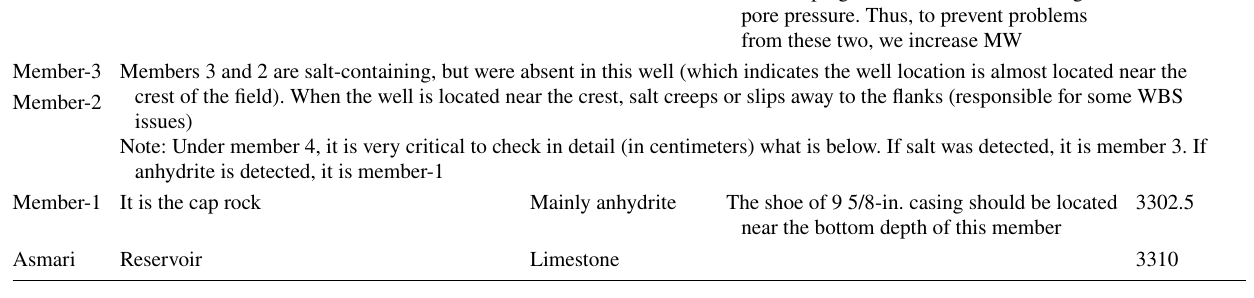
Table 6 Mud loss occurrences in well Z26 of Kupal field (used for calibration of the 𝜎 h estimations by MEM). These specified depths can be indicated for calibration of the minimum horizontal stress